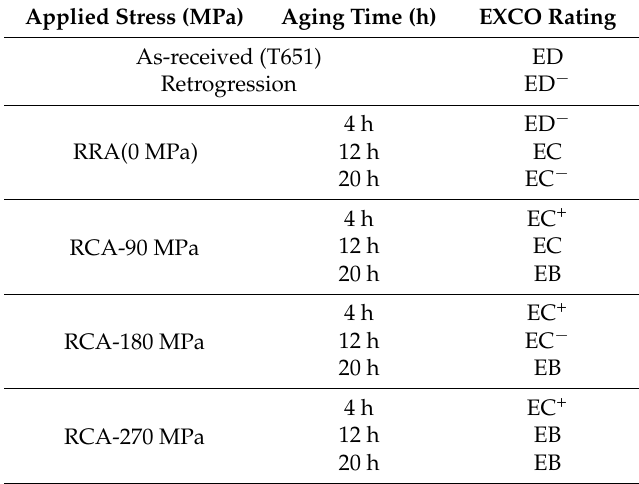
Table 2. The exfoliation corrosion rating of 7B04 aluminum